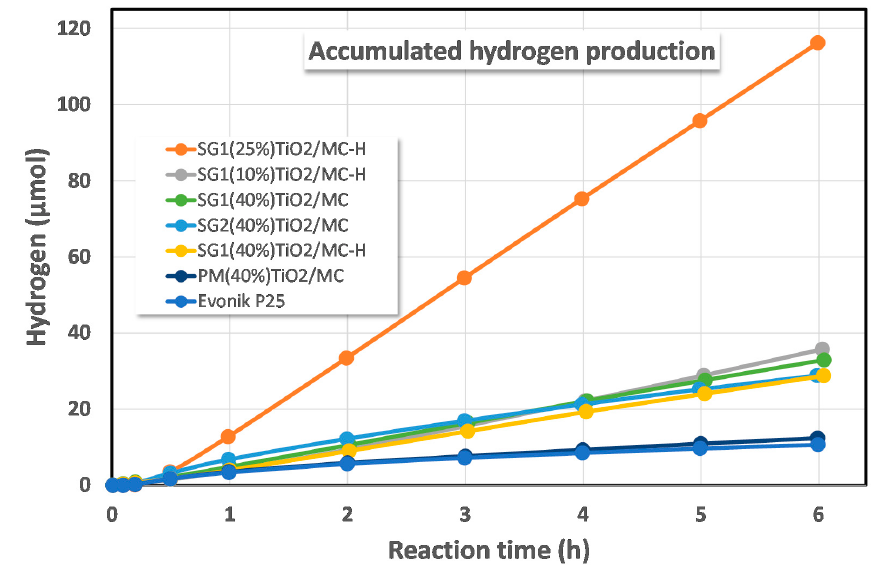
Figure 6. Accumulated hydrogen production from aqueous glycerol photoreforming for the synthesized TiO 2 -MC binary composites.